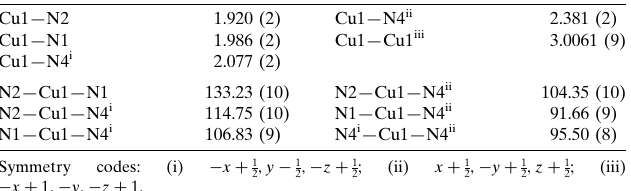
Selected geometric parameters (A˚ , (cid:1)